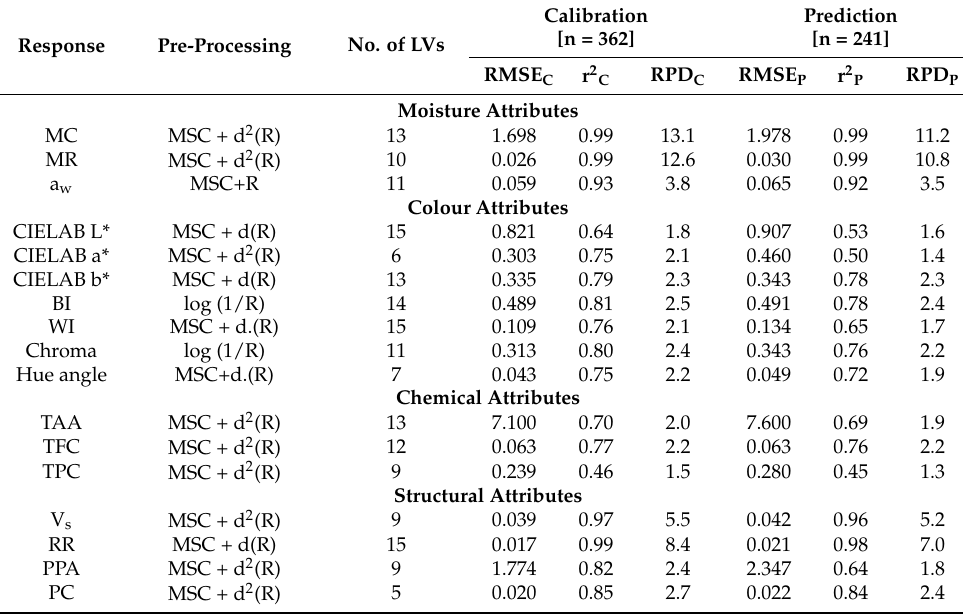
Table 3. Performance metrics of full wavelength PLSR calibration models.